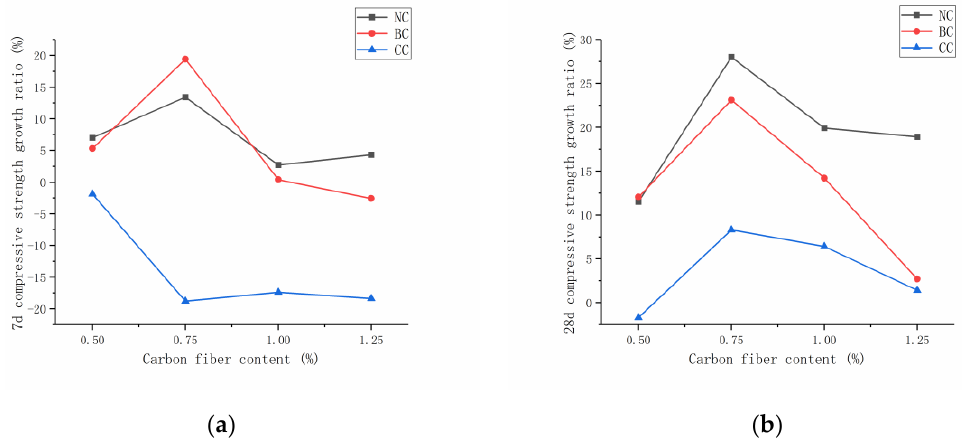
Figure 5. Compressive strength growth ratio at seven days and 28 days: ( a ) seven days, ( b ) 28 days.